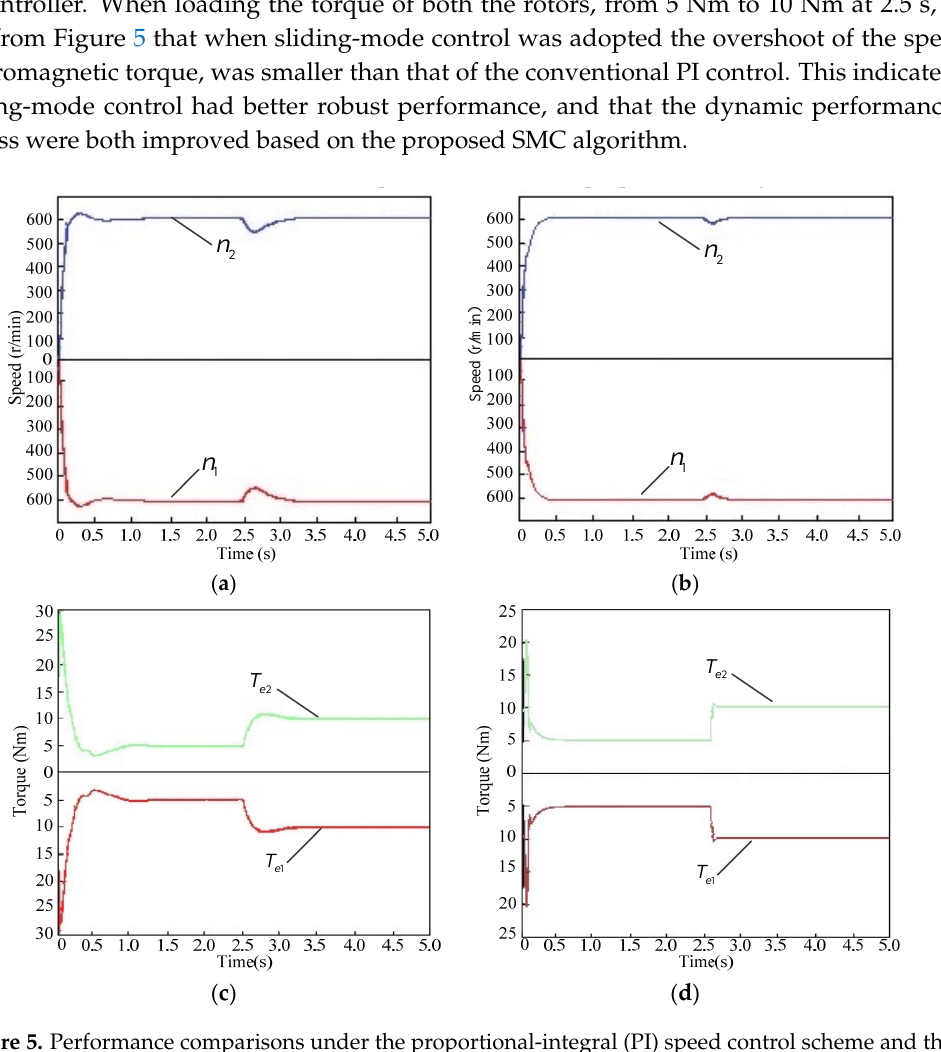
Figure 5. Performance comparisons under the proportional-integral (PI) speed control scheme and the sliding-mode control (SMC) speed control scheme. ( a ) Speed response (PI speed control); ( b ) speed response (SMC speed control); ( c ) torque response (PI speed control); and ( d ) torque response (SMC speed control).